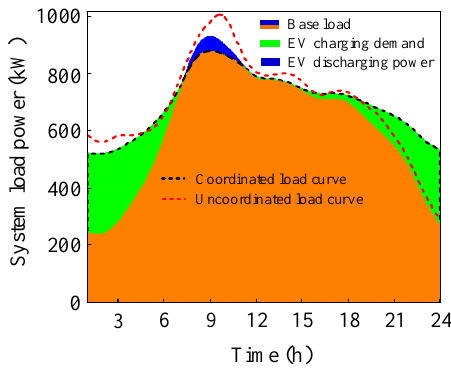
Figure 4. Total load profile with coordinated charge and discharge of an EV fleet.